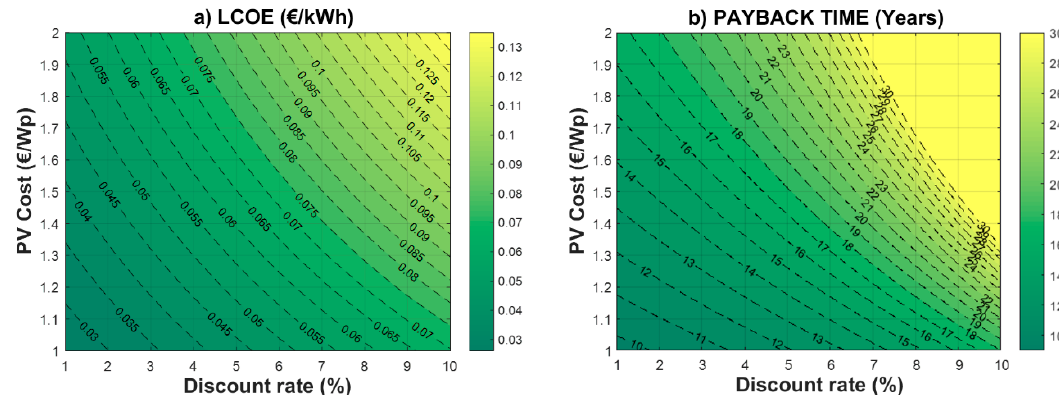
Figure 15. Economic analysis of Case 2: ( a ) levelized cost of electricity as function of discount rates and PV investment costs; and ( b ) payback time as function of discount rates and PV investment costs.